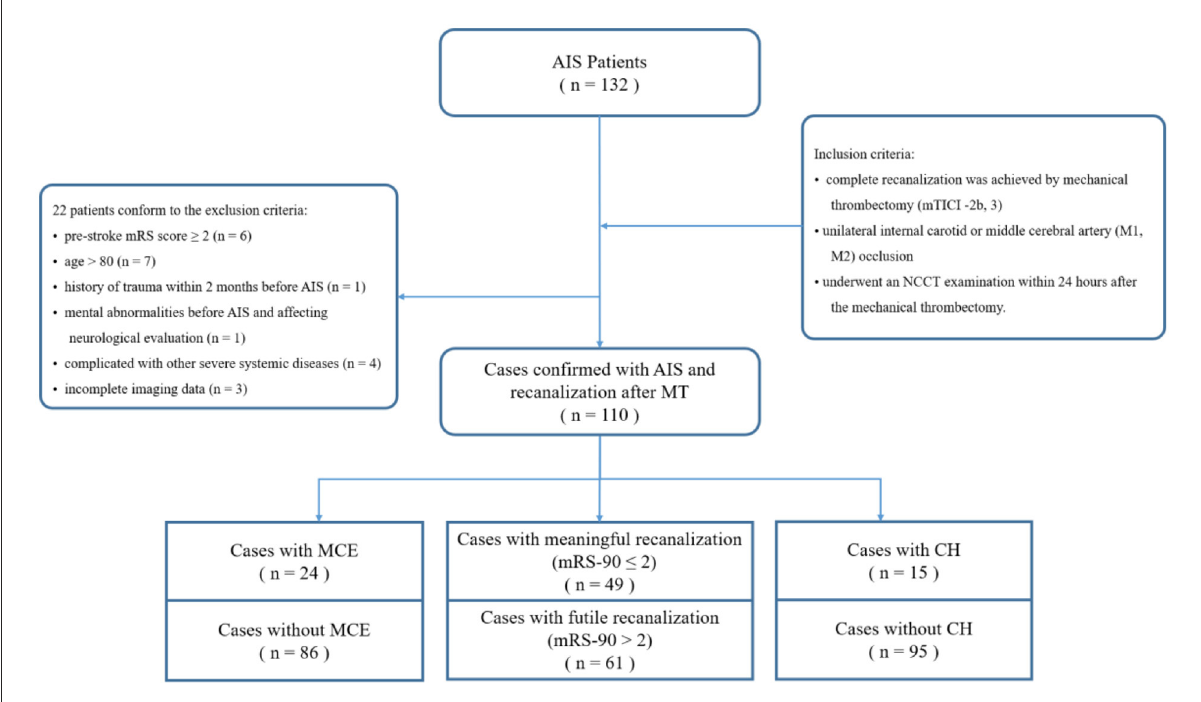
FIGURE1 The inclusion and exclusion